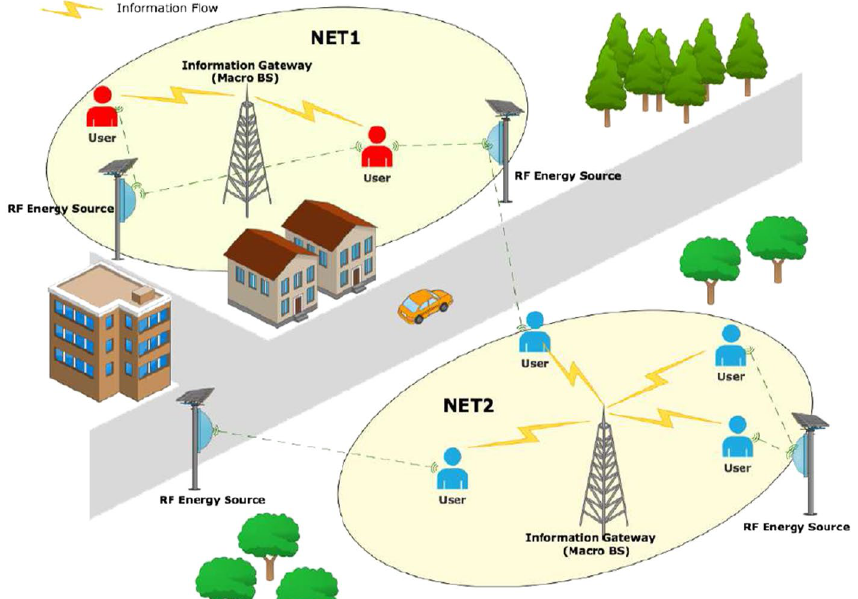
Fig. 1 Illustration of a SWIPT network structure showing a possible scenario of coexistence between WIT and